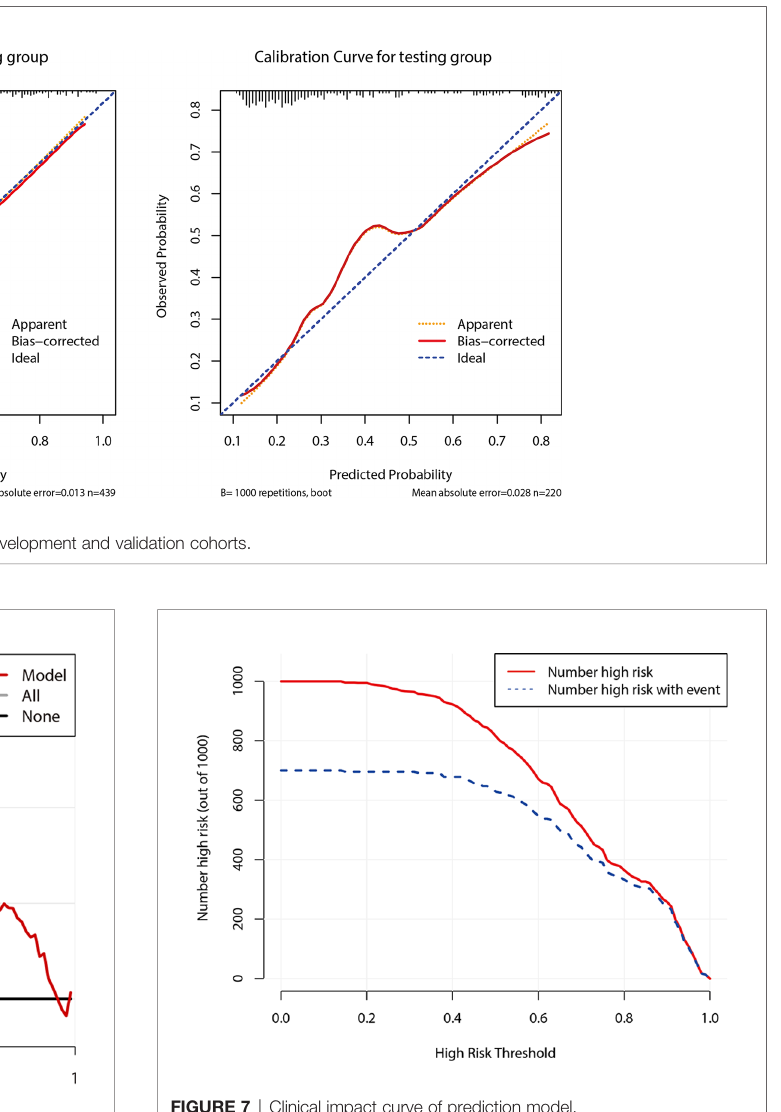
FIGURE 7 | Clinical impact curve of prediction